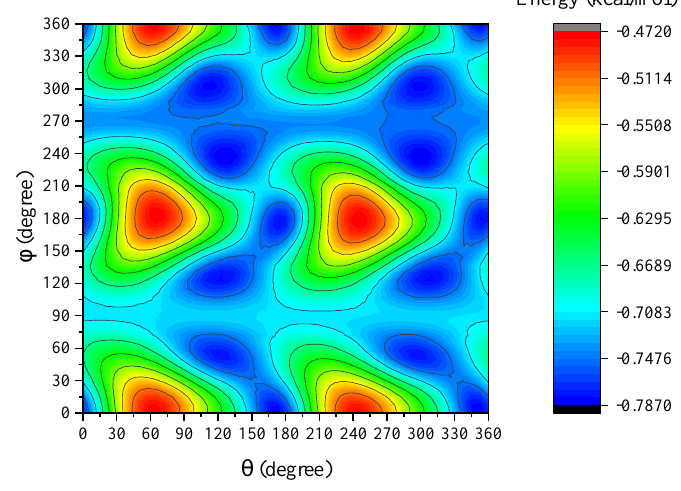
Figure 6. Contour plot of energy against θ and φ for interaction between dye molecule and TiO 2